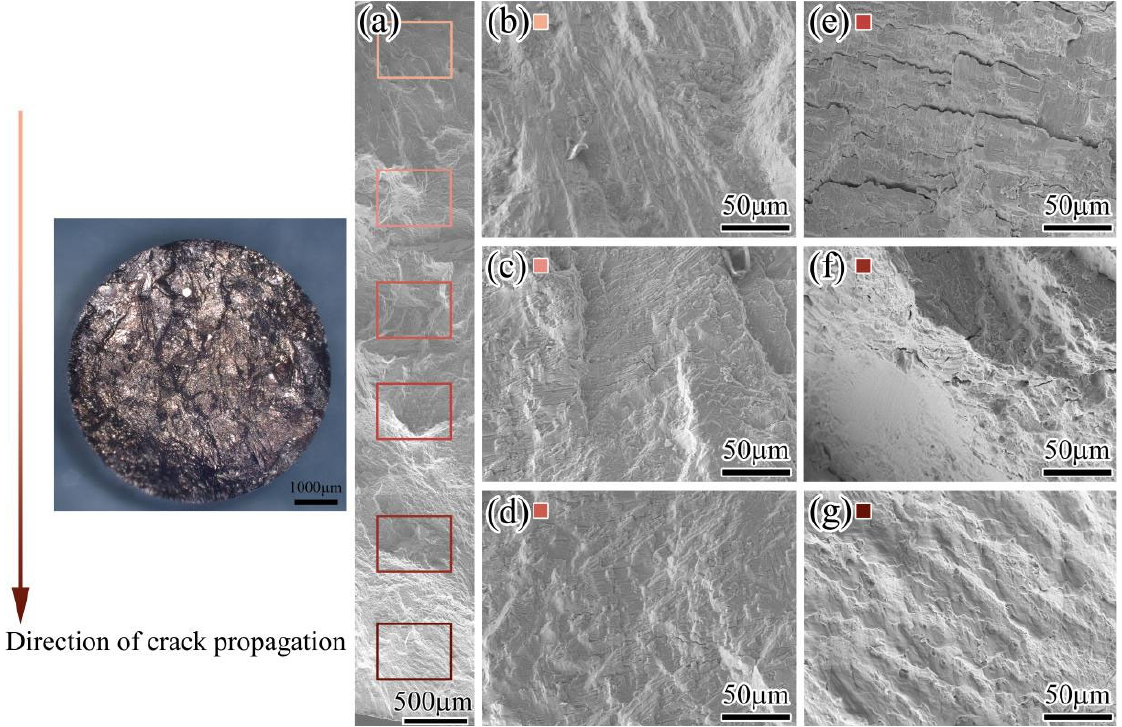
Figure 10. SEM fracture morphology of the LCF sample at 0.6% strain amplitude: ( a ) fracture direction of the main crack; ( b ) crack nucleation zone; ( c ) crack propagation zone; ( d ) middle region of crack propagation zone; ( e ) end region of crack propagation zone; ( f ) transient fracture zone; ( g ) shear lip.